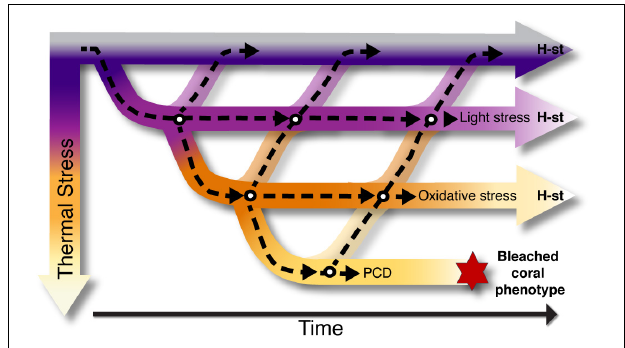
FIGURE 2 | Road map of homeostatic states leading to the bleached coral phenotype. Light and thermal responses triggered by ROS as a secondary cellular messenger, are considered as the signal for corals to initiate processes required for the establishment of new homeostatic states (H-st). Within the road map, several phenotypic steps take place (white circles) to achieve the new H-st. These states are time dependent and take place in the different compartments of the cell: in the chloroplast (light stress), symbiont cell (oxidative stress) and host cell (oxidative stress and Program Cell Death). All H-st are reversible when environmental conditions change, and the coral may return to previous homeostatic states. When thermal stress increases above the limits of tolerance of the symbiosis, the net accumulation of oxidative damage is deleterious and corals are unable to adjust by establishing a new homeostatic state, developing the bleached